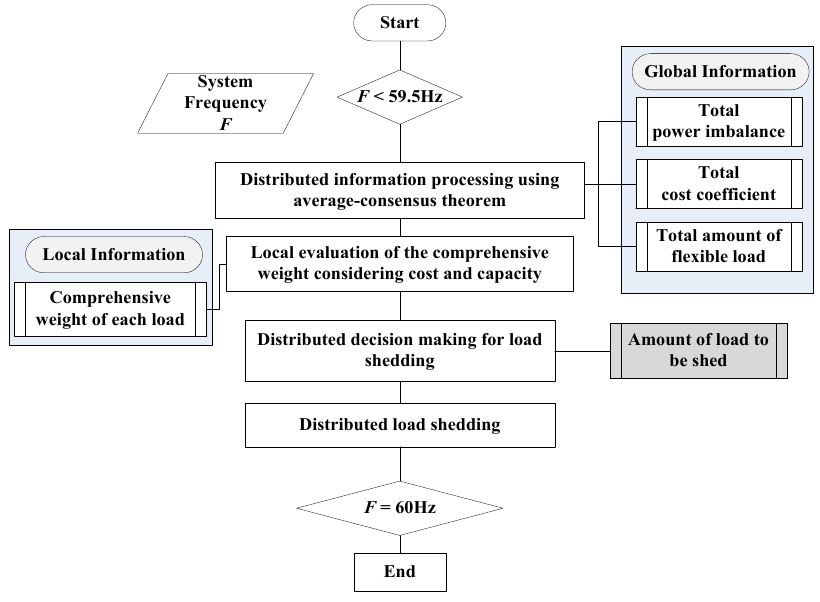
Figure 1. The flowchart of the proposed multiagent-based load